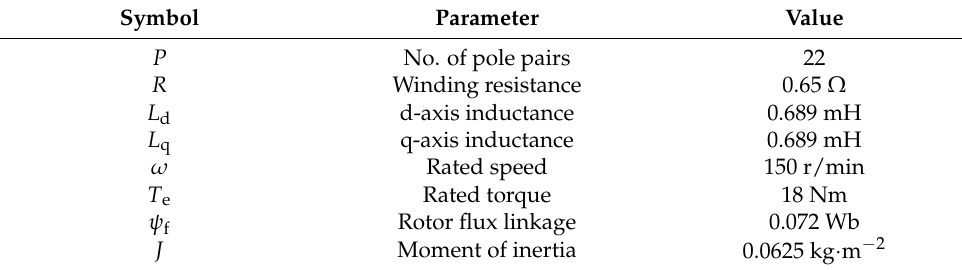
Figure 6. Normal operation experiment with the impulse current PWM technique and SDFT-LPF: ( a ) speed; ( b ) torque; ( c ) phase currents.